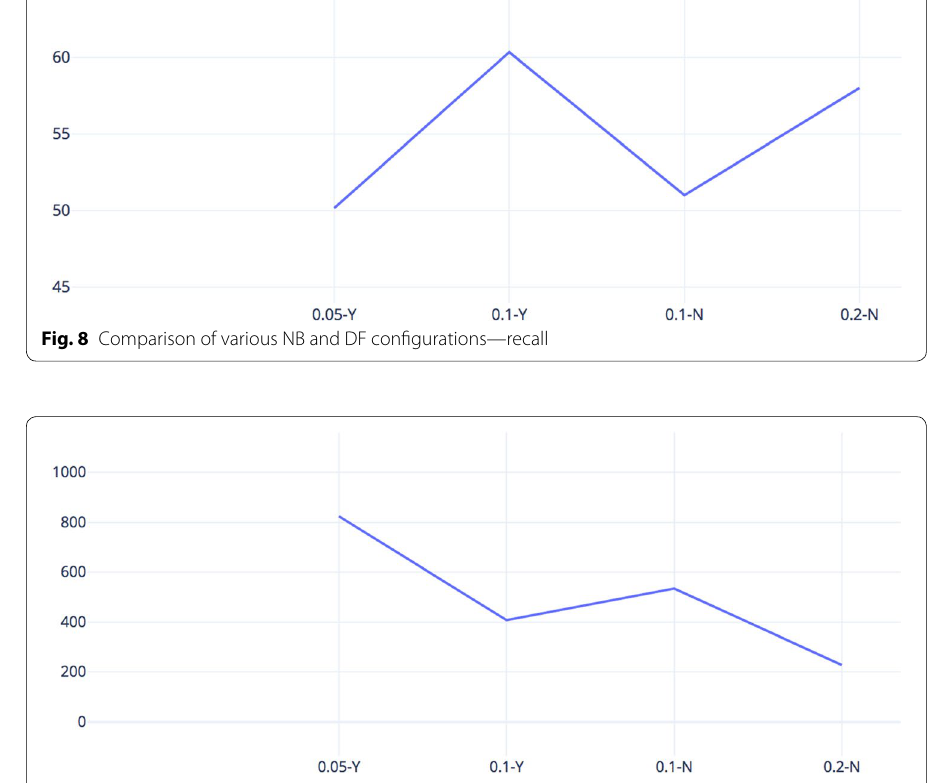
Fig. 9 Comparison of various NB and DF configurations—cluster